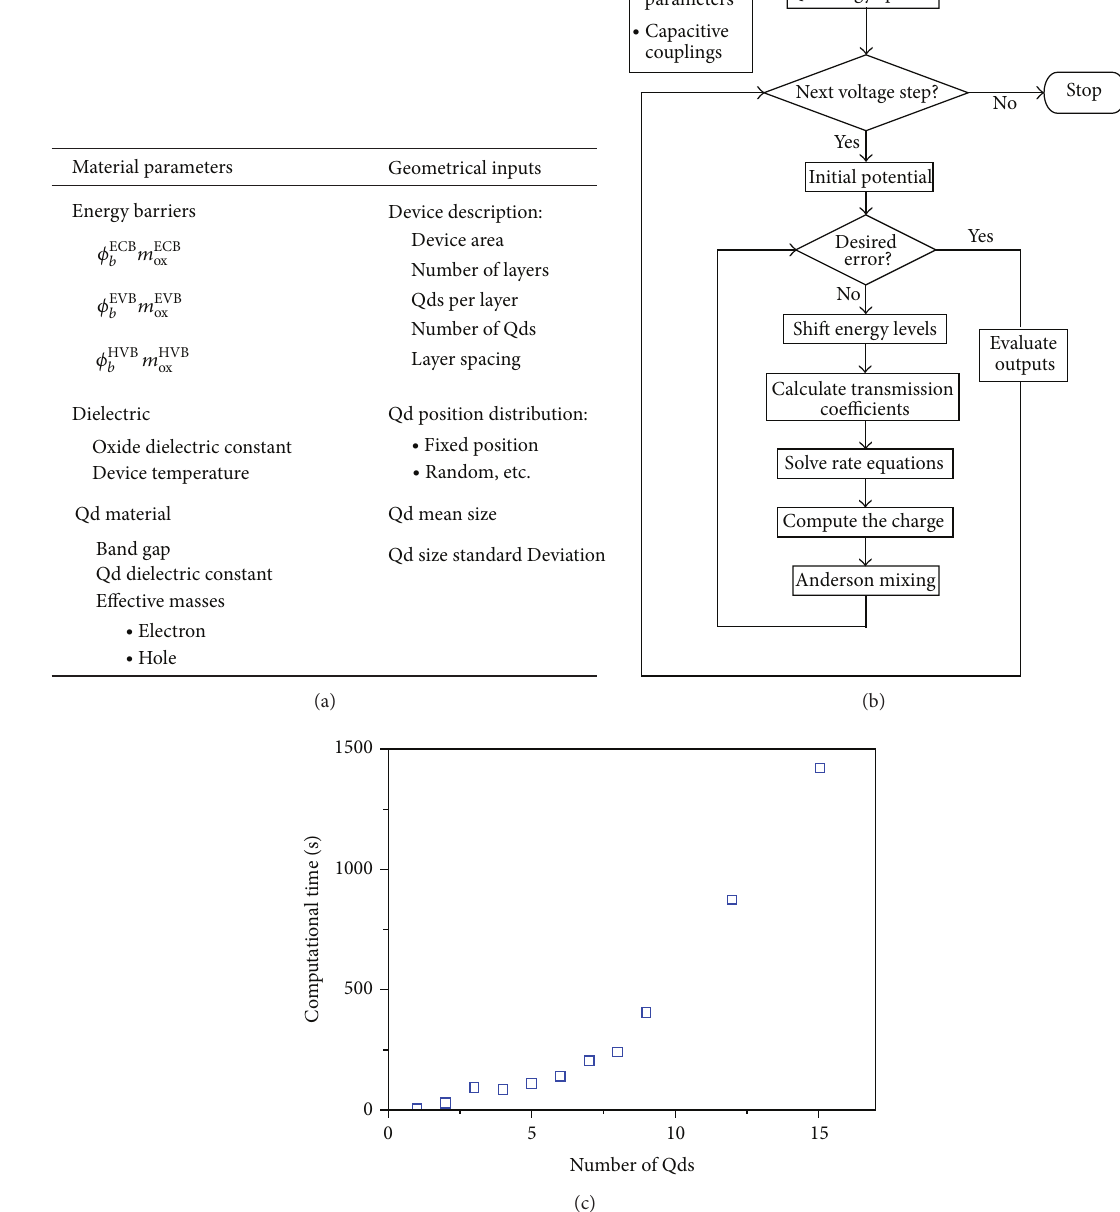
Figure 4: (a) List of the input parameters that describe the device. (b) Scheme flowchart of the self-consistent transport methodology. (c) Computational time versus number of simulated Qds. The time is referred for a single voltage point.